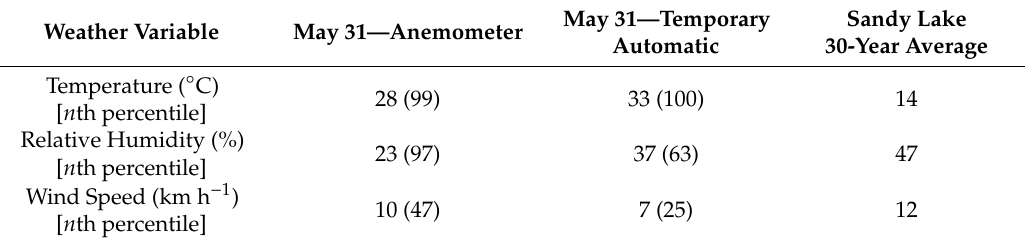
Table 1. May 31 temperatures (on site sonic anemometer and Pelican Mountain temporary weather station) and 30-year average (Sandy Lake Permanent weather station). Values followed by percentile from Sandy Lake 1987–2016 data in the month of May.